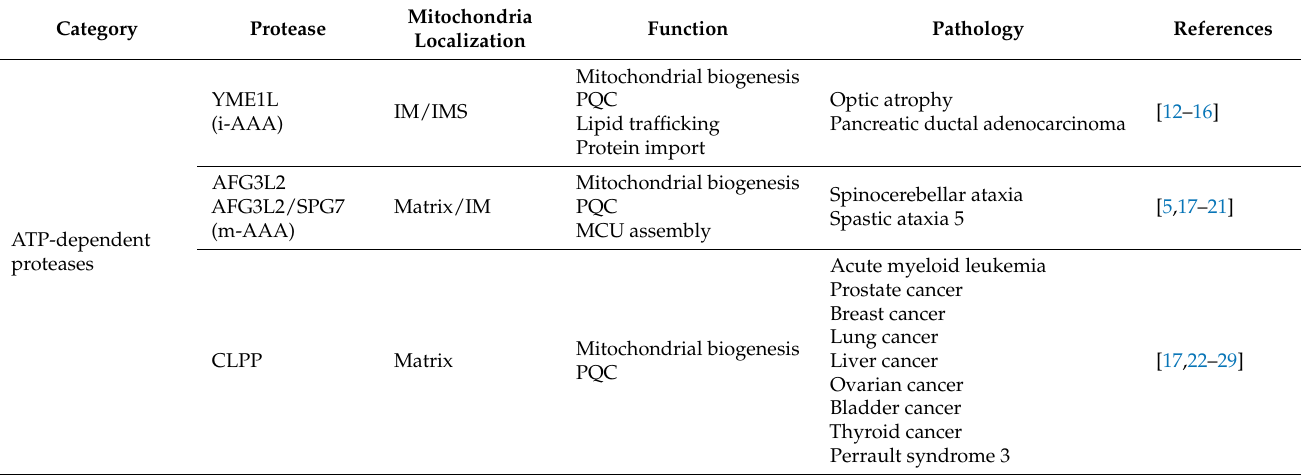
Table 1. Intrinsic mitochondrial proteases, functions, and related